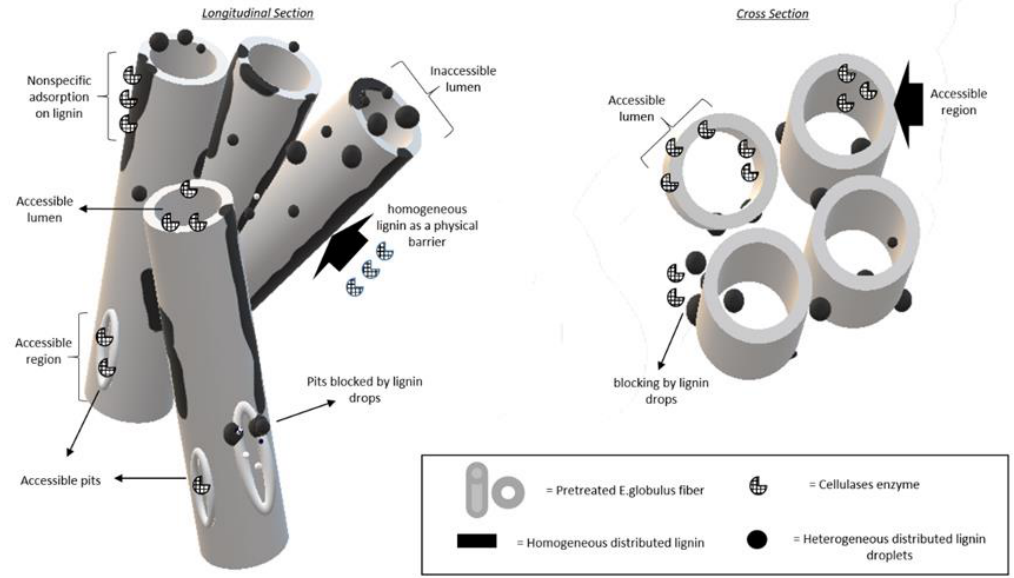
Figure 9. Hypothetical diagrammatic presentation of the effect of pre-treatment on the formation of micro and nano lignin droplets generating a heterogeneous distribution of lignin, increasing the areas of enzymatic microaccessibility and subsequent digestion of cellulose. Pre-treated fibres are represented lengthwise on the left and in cross section on the right. S 0 8.53.